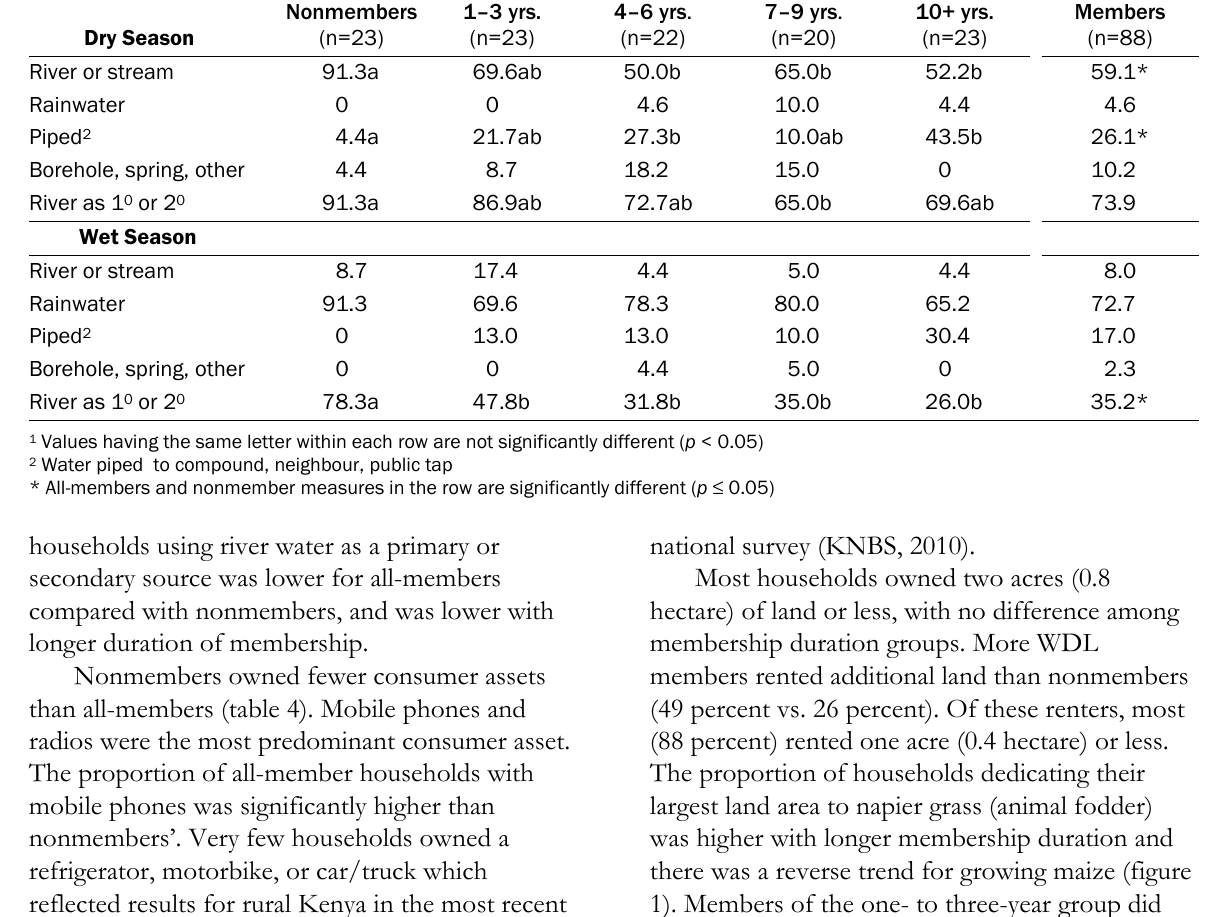
Table 4. Consumer Assets Ownership, by Dairy Group Membership Duration (% of households)